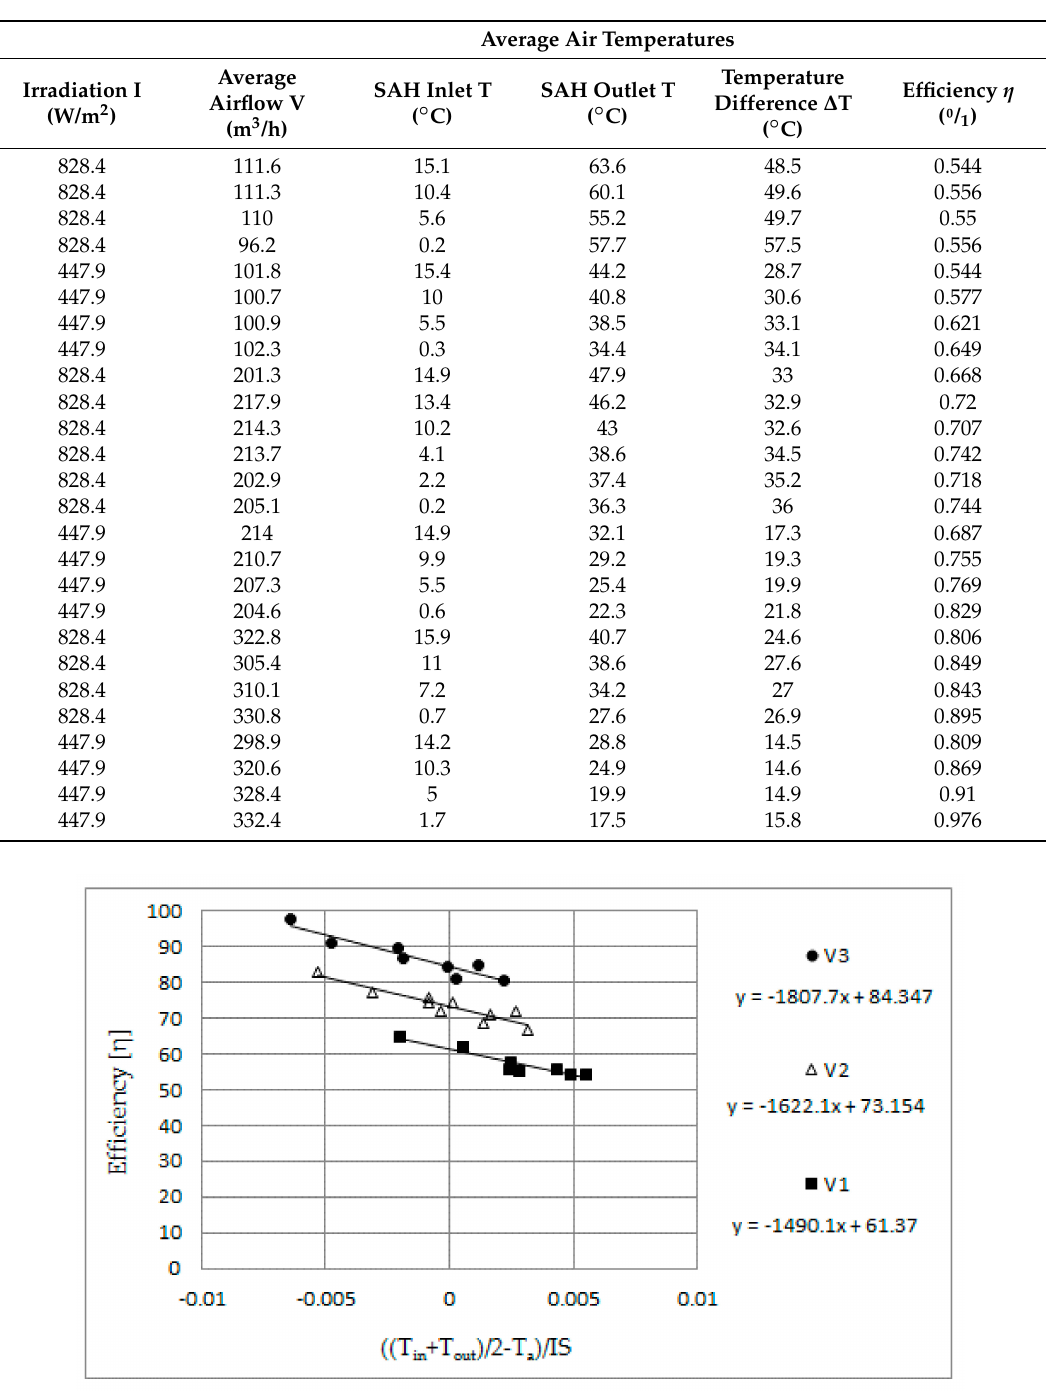
Figure 5. Curves of efficiency for the different airflows studied.